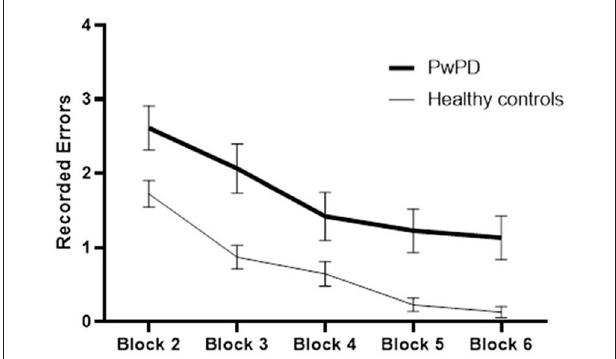
FIGURE 2 | Practice-related improvement in performance (time required to complete the VR game in seconds) across blocks in PwPD and healthy controls. Post-hoc analysis indicated significant difference between Block 6 and Block 2 in both groups. In healthy controls, significant differences were also found between (Block 2 and Block 3) and between (Block 4 and Block 5). In PwPD, significant differences were also found between (Block 2 and Block 3) and between (Block 3 and Block 4).